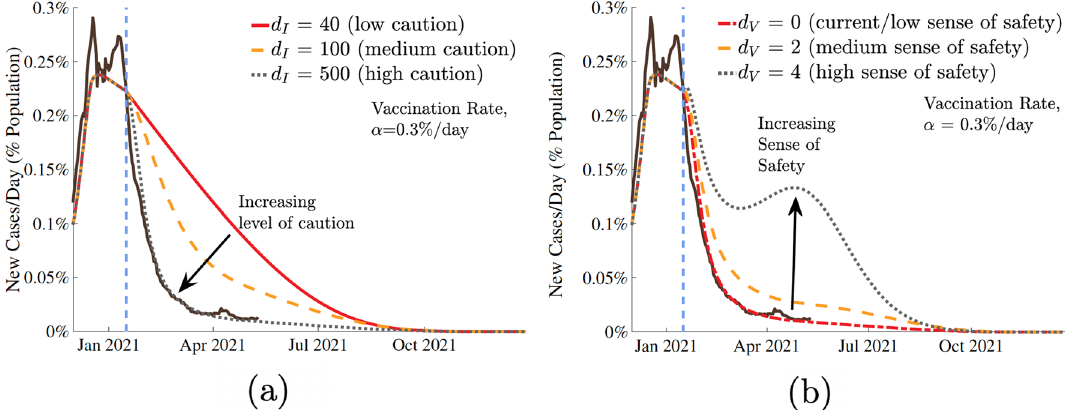
Figure 3. Effect of ( a ) sense of caution factor, d I , and ( b ) sense of safety factor, d V on pandemic trajectory. The dashed blue bar represents the introduction of a vaccine with 95% effectiveness, at a fixed rate of 0.3% of the population per day. Extreme values of d I represent the extremes of social behavior: the most responsive (black dotted) and the least (red). Sensitivity analysis in ( a ) considered a fixed sense of safety d V = 0 , and in ( b ) considered a fixed level of caution d I = 500